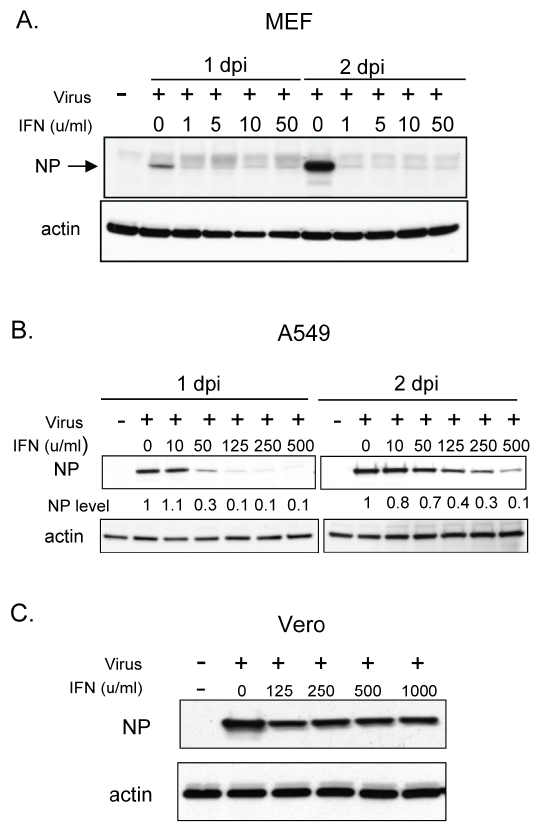
Figure 3. Immunoblotting analysis of viral protein expression. MEF cells (A), A549 cells (B) and Vero cells (C) were pretreated with mouse IFN- b (A) or human IFN- b (B and C) at different concentrations as indicated for 16 hr. Cells were then infected with Candid # 1 virus at an MOI of 3. Cell lysates were prepared at 1 and 2 days p.i. from MEF cells and A549 cells, or at 2 days p.i. from Vero cells. The viral NP protein was detected with a monoclonal mouse anti-JUNV NP antibody (AG12, BEI) by Western Blotting assay. Equal loading of samples was confirmed by immunoblotting of the same membranes with an antibody to b -actin protein (Santa Cruz). Relative NP protein level in A549 cell samples is shown (B) after densitometry measurement and normalization to the actin protein